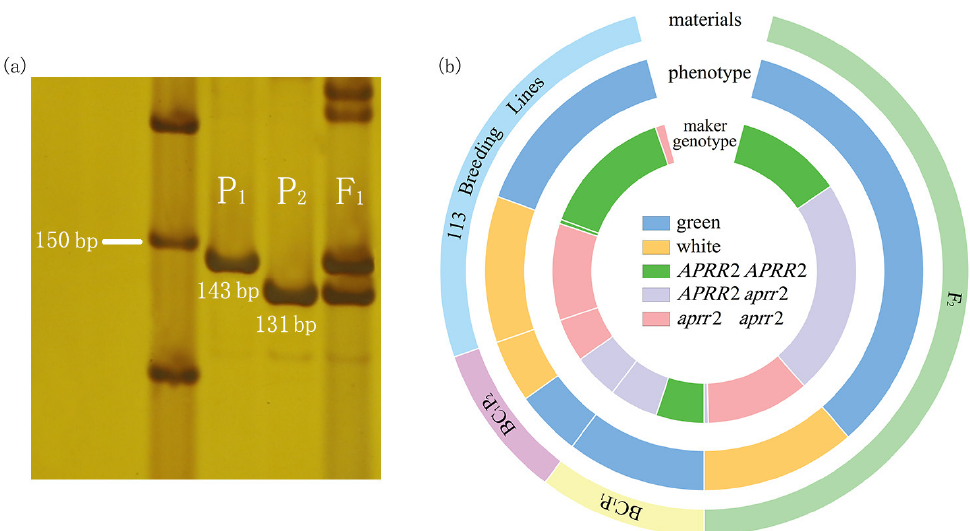
Figure 3. Segregation analysis of Indel marker fc84.40. ( a ) PCR amplification results of fc84.40 marker in P 1 , P 2, and F 1 . ( b ) The verification of fc84.40 marker in two backcrossing populations, 2794 F 2 populations, and 113 breeding lines. The outer circle indicates the populations used for segregation analysis; the middle circle indicates the phenotype of the materials; the inner circle indicates the maker genotype of the materials.